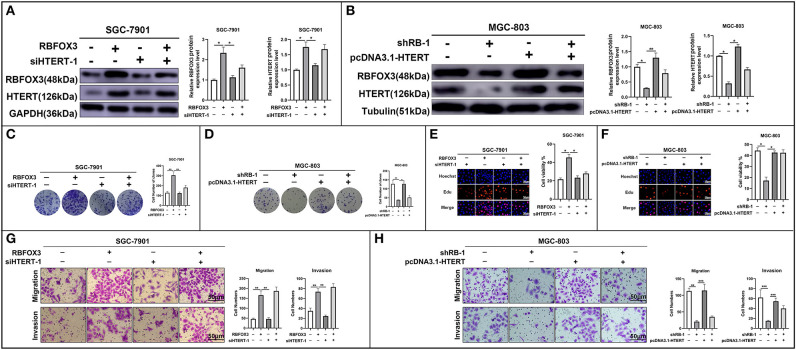
RBFOX3 promotes gastric cancer multiplication and invasion by up-regulating HTERT expression. (A) The silencing of HTERT (siHTERT-1) repressed the up-regulation of HTERT expression in SGC-7901-RBFOX3 cells. (B) Overexpression of HTERT (pcDNA3.1-HTERT) attenuated the HTERT expression in MGC-803-shRB cells. (C–H) Colony formation, Edu, and invasion assays showing that the knockdown or the overexpression of ectopic HTERT significantly rescues the RBFOX3-overexpressed or RBFOX3-silenced cell division and invasion observed in SGC-7901 and MGC-803 cells. *p < 0.05, **p < 0.01.